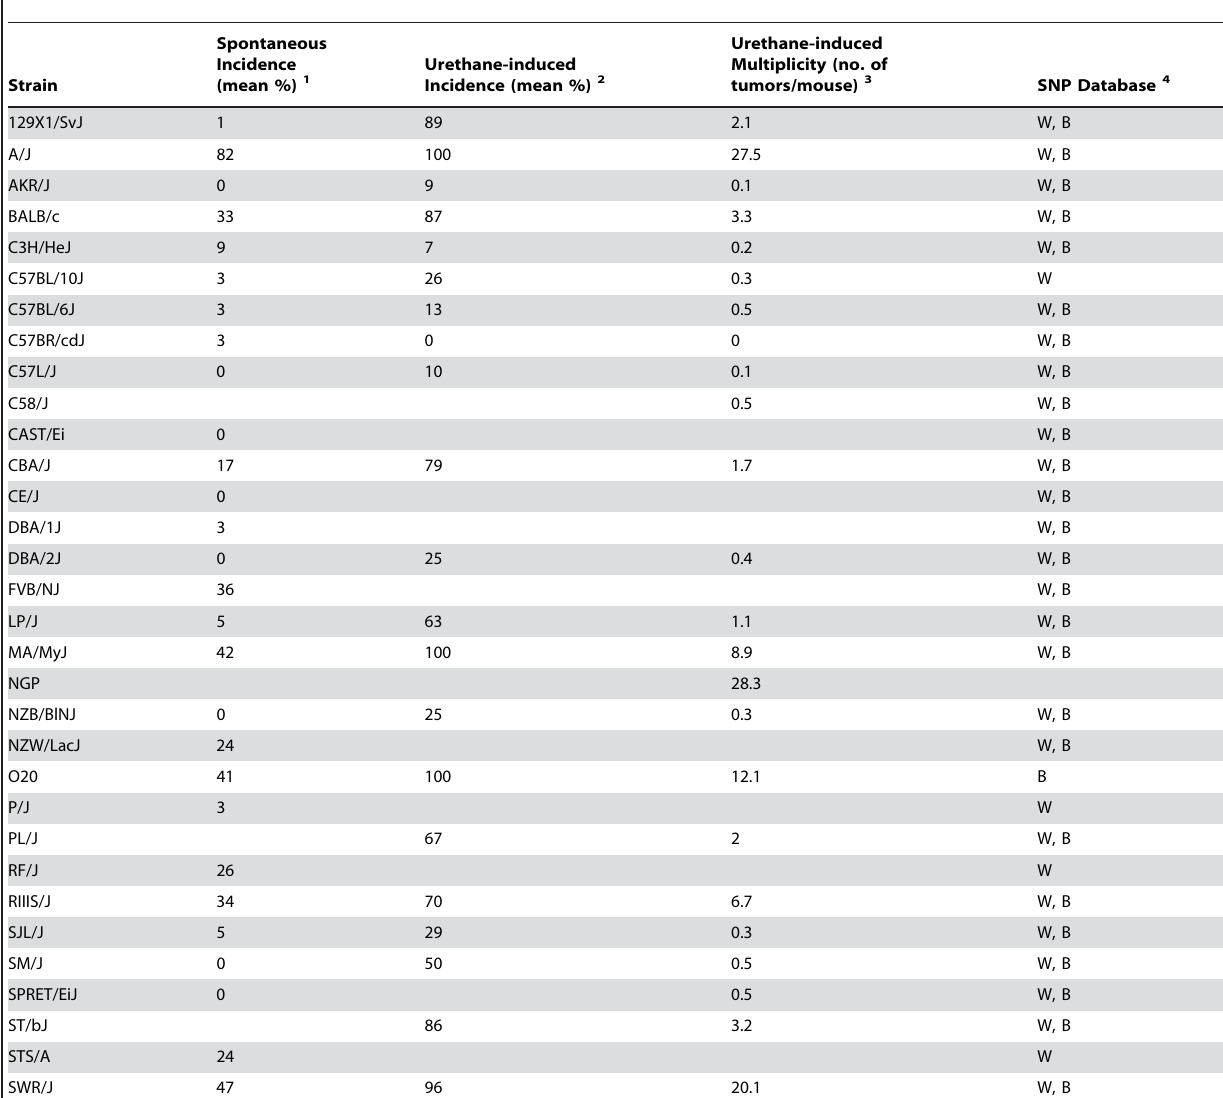
Table 1. Lung tumor phenotypes (spontaneous and urethane-induced incidence and urethane-induced tumor multiplicity) of mouse inbred strains used in this